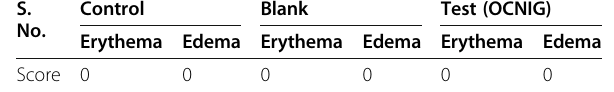
Table 8 Draize score for all groups of rabbits S.